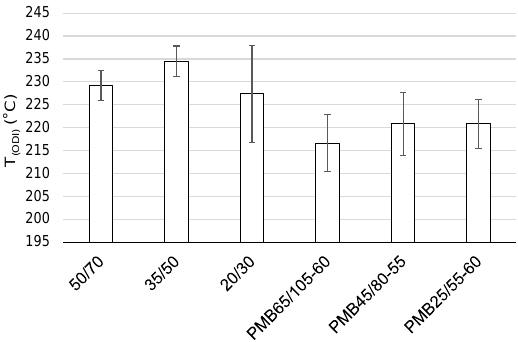
Figure 9. Average T (ODI) for individual binders.